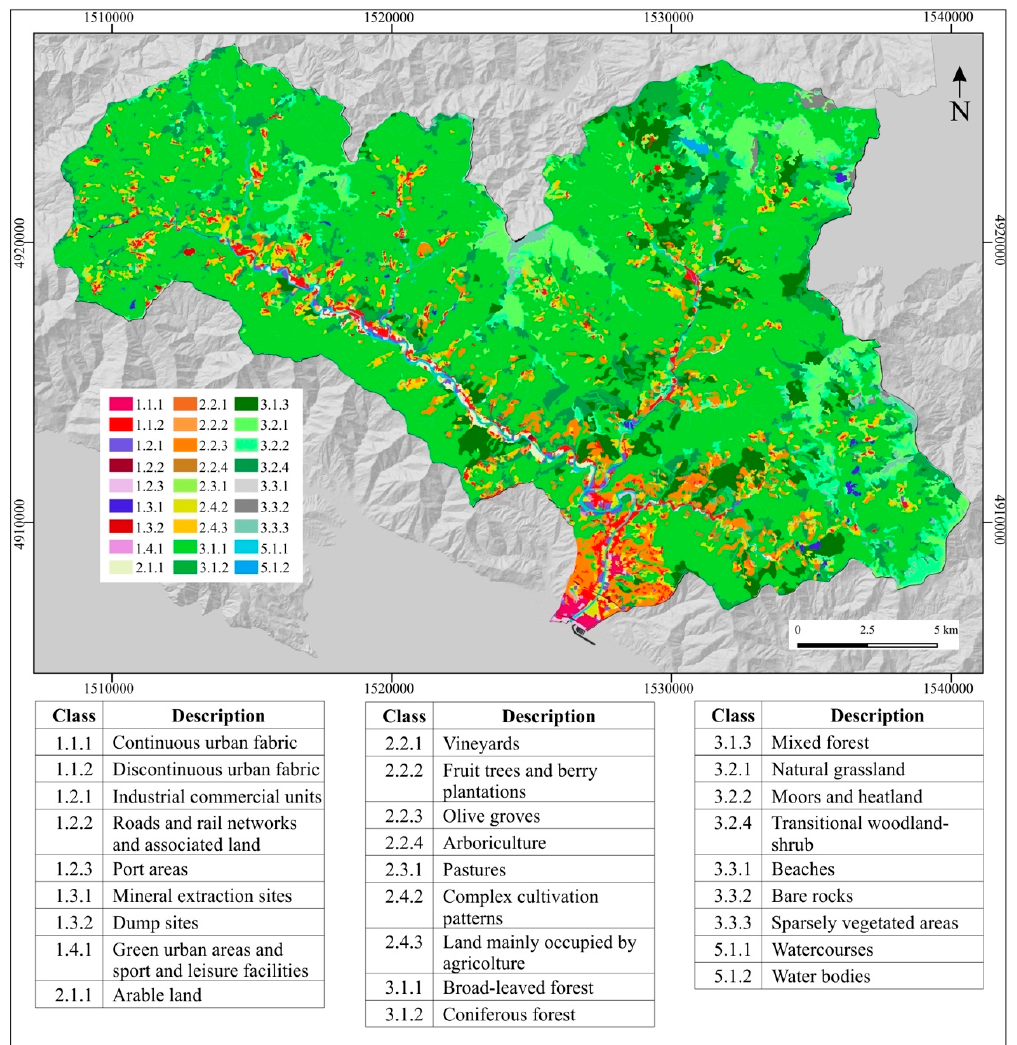
Figure 5. Land-use map of the Entella River basin.